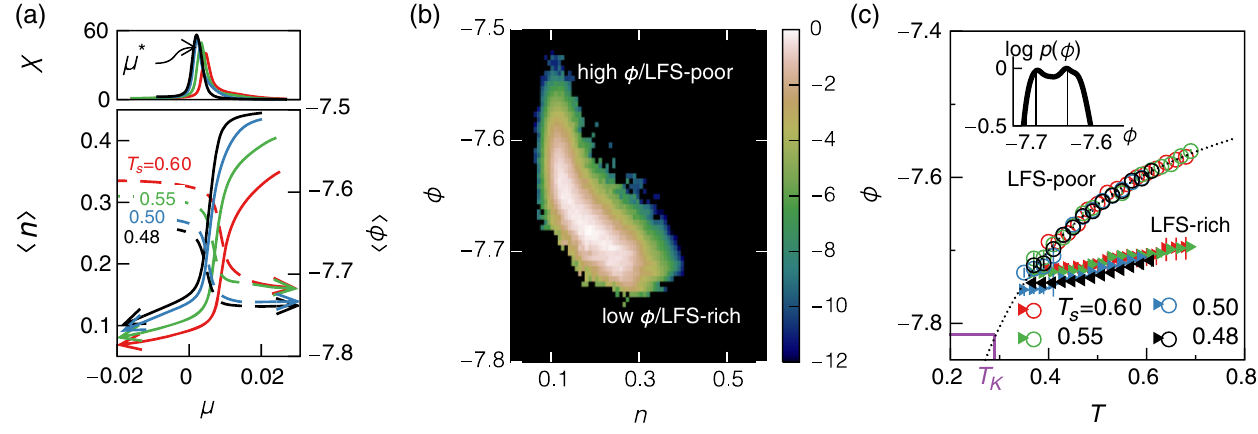
FIG. 3. The inherent state energy drops across the dynamical transition. (a) Signature of the dynamical phase transition: The average trajectory population h n i of LFS (continuous lines) shows a sudden increase at a nonzero μ . Top panel: The susceptibility χ ð μ Þ T s ; μ quantifying the magnitude of fluctuations in LFS populations is shown, the peak of which defines μ ISE h ϕ i of central configurations (dashed lines) drops substantially. (b) Logarithm of the joint probability of LFS population n and T s ; μ 0 . 55 and μ ¼ 0 . 005 ≈ 0 . 7 μ . (c) Typical energies of the two populations as a function of temperature: LFS-poor states ISE ϕ , for T s ¼ (cid:4) (circles) essentially follow the equilibrium liquid curve (dotted line), while LFS-rich ones (filled triangles) are characterized by much lower energies, with a T -dependent tail at low temperatures. Inset: ISE probability distribution p ð ϕ Þ evaluated at μ ¼ μ s